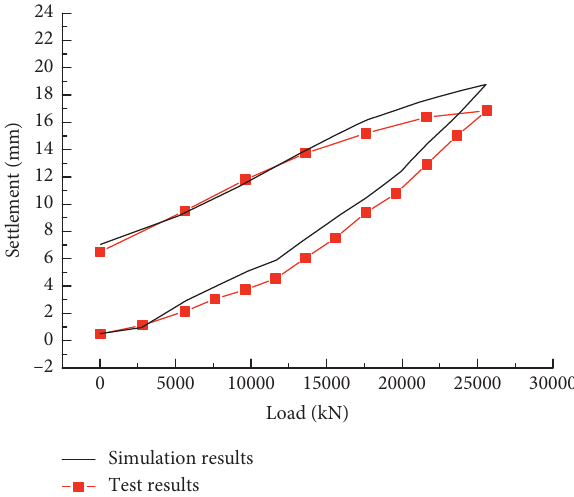
Figure 24: Comparison of the simulated deformation results and monitoring data of the model.